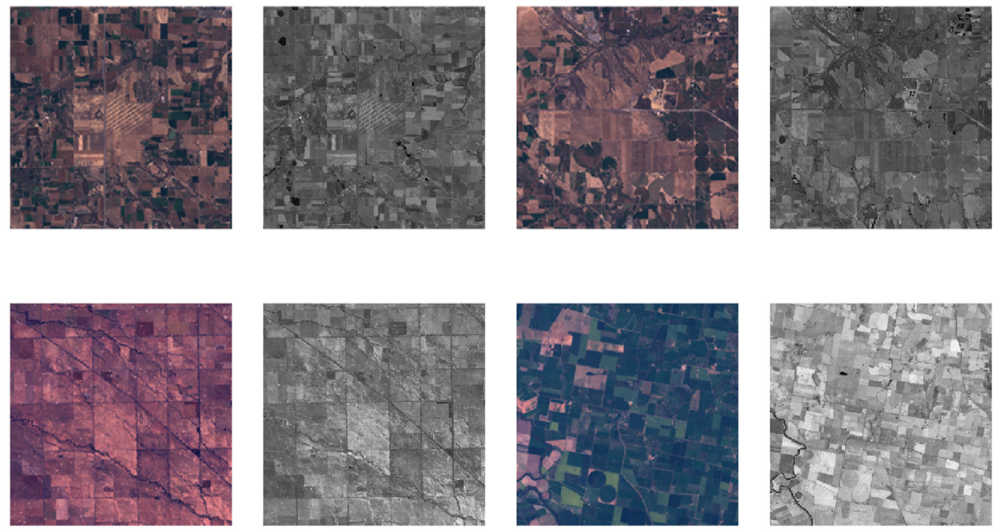
Figure 8. Four image